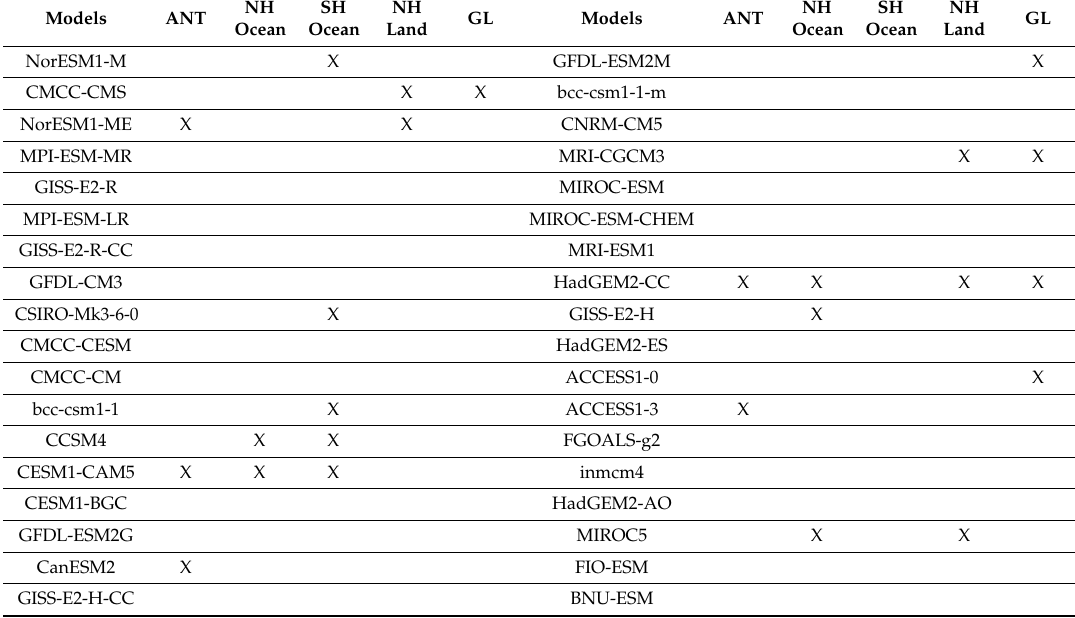
Table 1. The list of the models used in this study. For each study region the selected models based on Bias, RMSE, or both are labeled by “B”, “R”, or “X”, respectively. ANT and GL are for Antarctica and